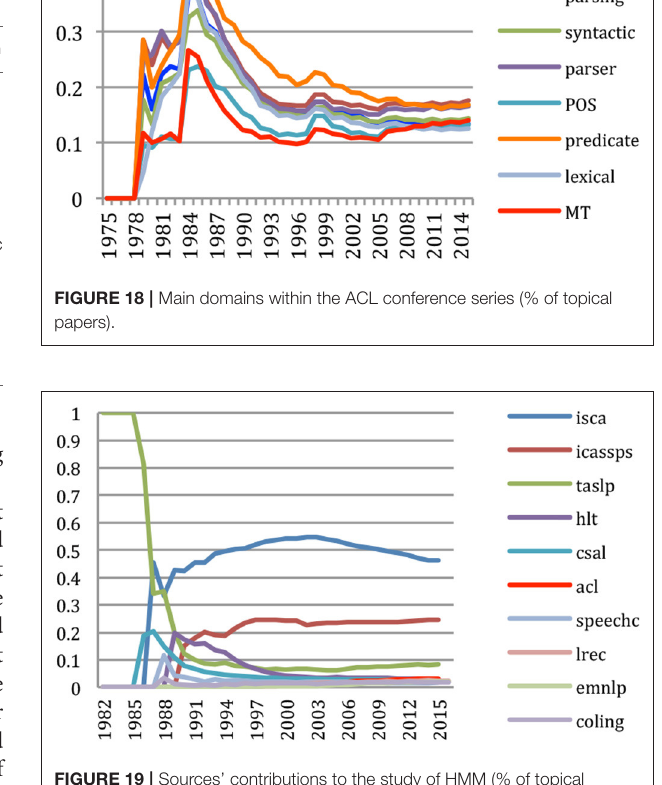
TABLE 6 | Global ranking of the importance of the sources overall and separately for Speech and NLP. Rank